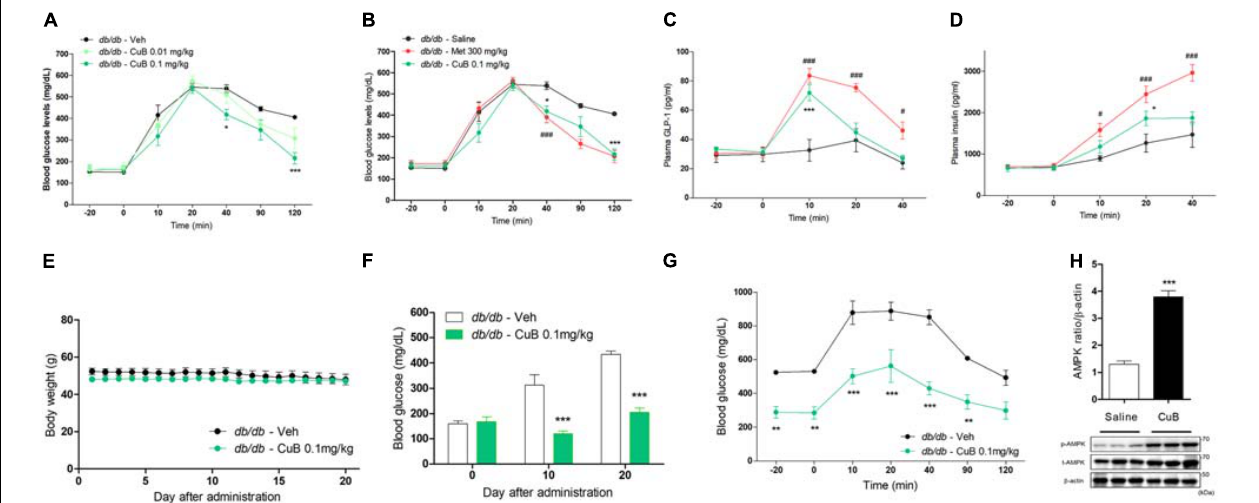
FIGURE 1 | Cucurbitacin B ameliorates hyperglycemia in db/db mice. (A) Fasted mice were administrated with CuB 0.01 (Mint) and 0.1 mg/kg (Green). (B) CuB-mediated hypoglycemic effects were similar to Metformin 300 mg/kg (Red). Blood glucose were measured using Acu-Check performa in end of tail. Data are presented as a Mean ± SEM, n = 8 of the LEPR − / − ( db/db ) mice group treated with or without CuB. ### P < 0.001 (Meformin) vs. vehicle, ∗∗∗ P < 0.001, ∗ P < 0.05 (CuB) vs. vehicle. (C,D) The plasma GLP-1 and plasma insulin were measured using multiplex system. Data are presented as a Mean ± SEM, n = 8 of the LEPR − / − ( db/db ) mice group treated with or without CuB. # P < 0.05, ### P < 0.001, (Meformin) vs. vehicle ∗ P < 0.05, ∗∗∗ P (CuB) < 0.001 vs. vehicle. Met, Metformin; CuB, Cucurbitacin B. Metformin was used for positive control of hypo-glycaemic agents. (E) Body weight was compared with treatment of vehicle or, of CuB 0.1 mg/kg per day and was measured for 20 days on db/db mice. Data are presented as a Mean ± SEM, n = 8 of the LEPR − / − ( db/db ) mice group treated with or without CuB. (F) Every 10 days, fasting blood glucose levels were measured on db/db mice. Data are presented as a Mean ± SEM, n = 8 of the LEPR − / − ( db/db ) mice group treated with or without CuB. ∗∗∗ P < 0.001 vs. vehicle. (G) After treatment with vehicle or, CuB (0.1 mg/kg per day for 20 days), OGTT was performed on db/db mice. Data are presented as a Mean ± SEM, n = 8 of the LEPR − / − ( db/db ) mice group treated with or without CuB. ∗∗ P < 0.01, ∗∗∗ P < 0.001 (CuB)